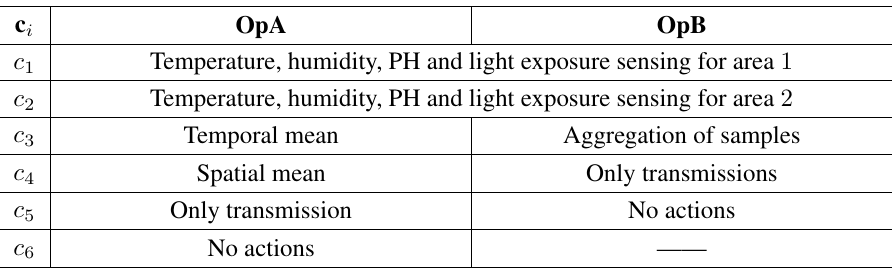
Table 2. Sub-operations for OpA and OpB, for two monitored areas.